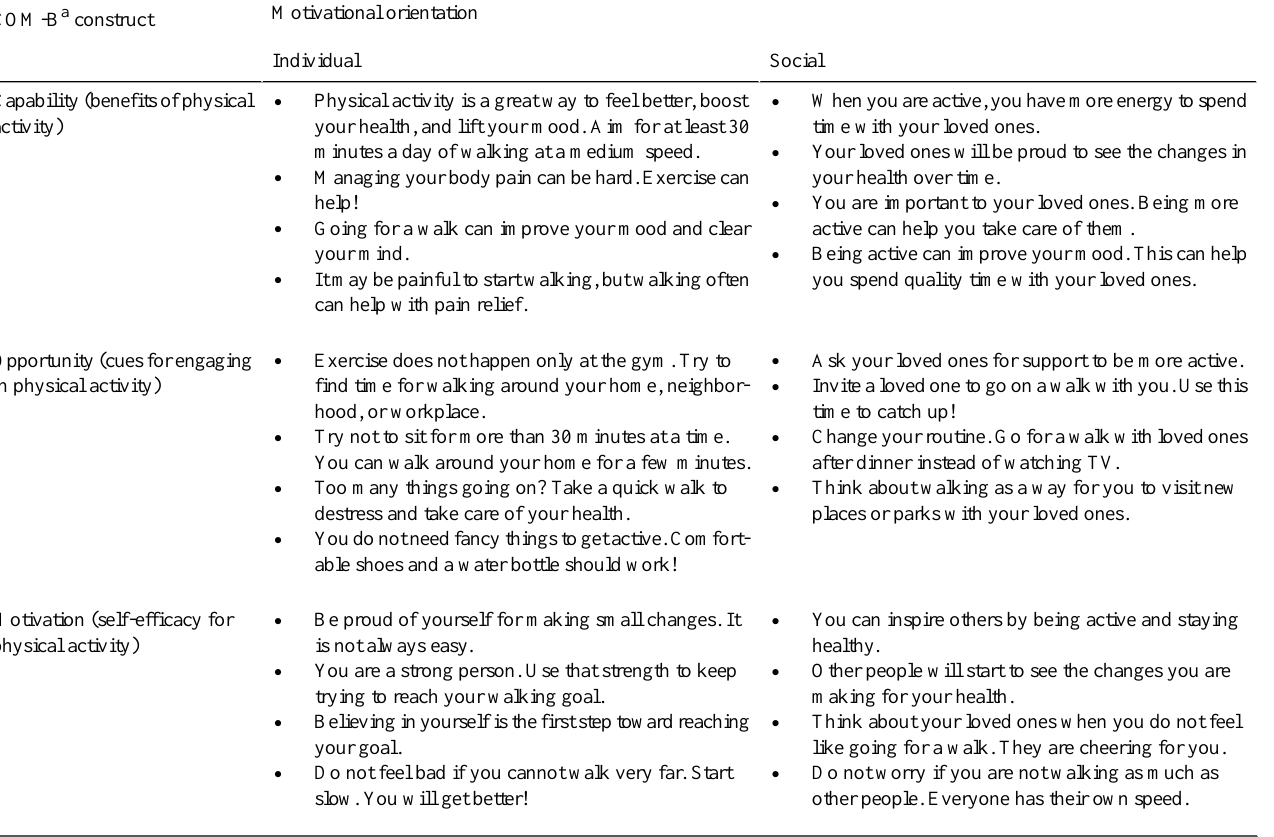
Table 2. Sample of final selected messages by theoretical construct category.